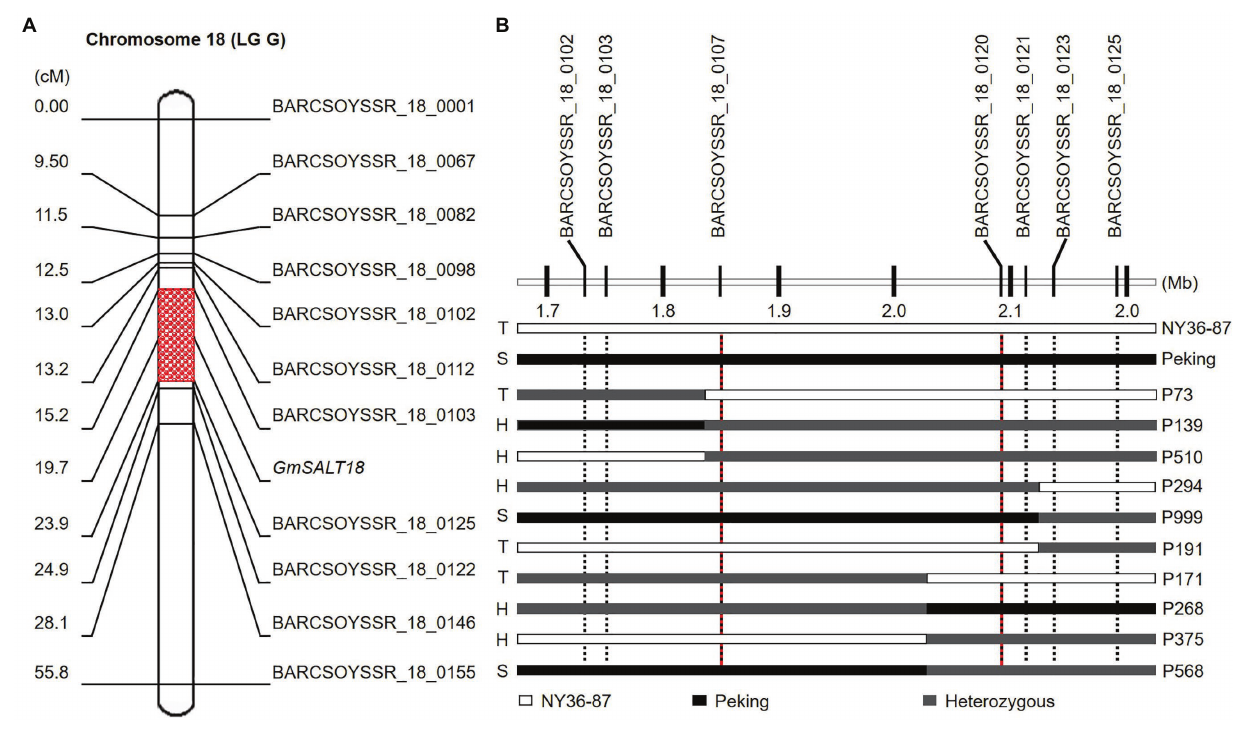
FIGURE 3 | Mapping the salt tolerance locus in the Peking × NY36-87 population. (A) Salt tolerance-related locus mapped on soybean Chr. 18 using simple sequence repeat (SSR) markers. (B) Fine mapping of salt-tolerance gene. T, S, and H indicate tolerant, sensitive, and heterozygous (segregating) phenotype,